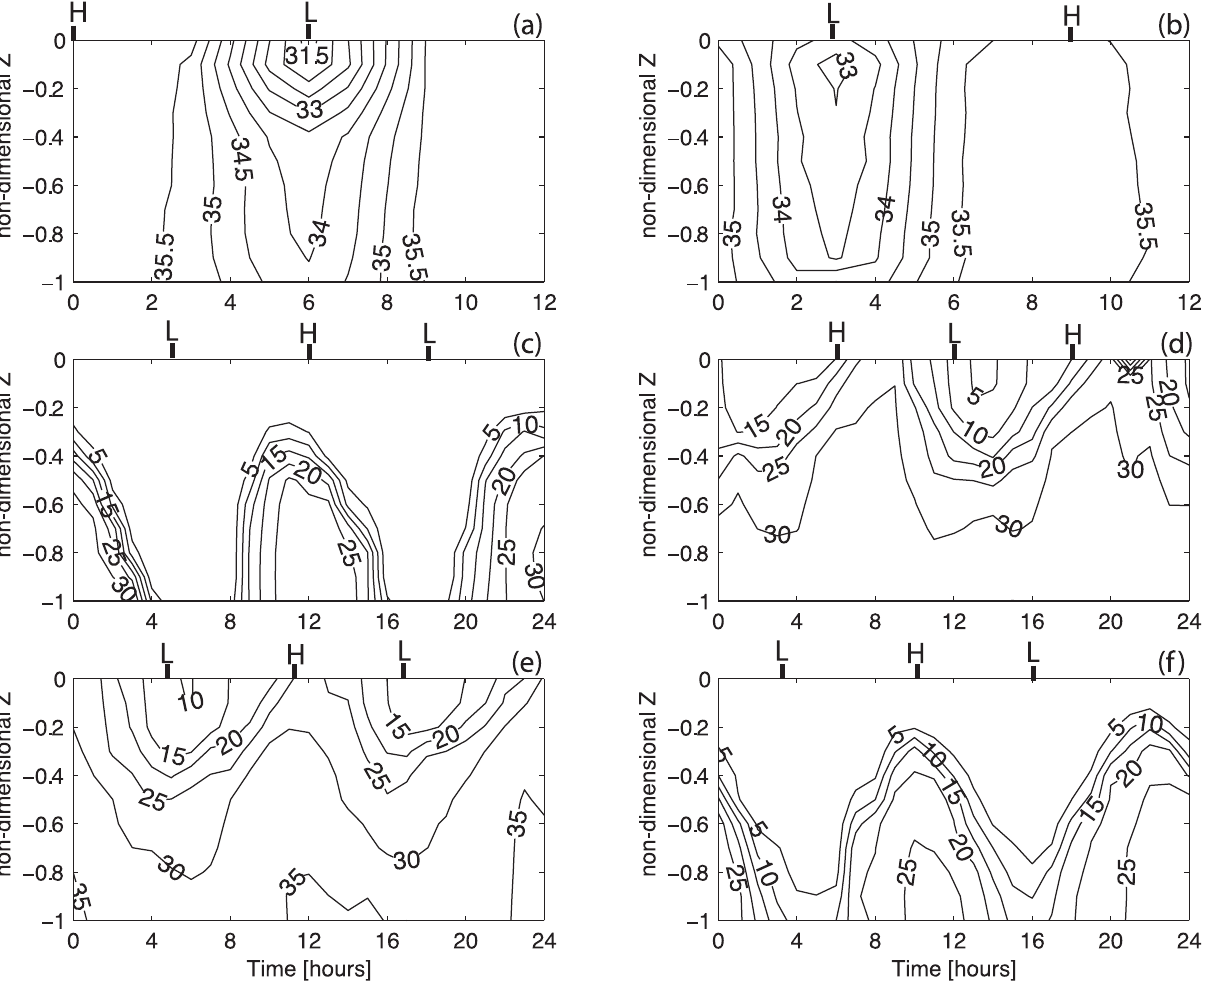
Figure 2. Contour figures of salinity as a function of the non-dimensional depth ( Z ) and time for all survey periods. H and L indicate the local high and low-water. (a) 21/02/2002 (station A); (b) 28/02/2002 (station A); (c) 15/01/2004 (station B); (d) 16/06/2004 (station B); (e) 27/08/ 2004 (station B); (f) 03/12/2004 (station B).